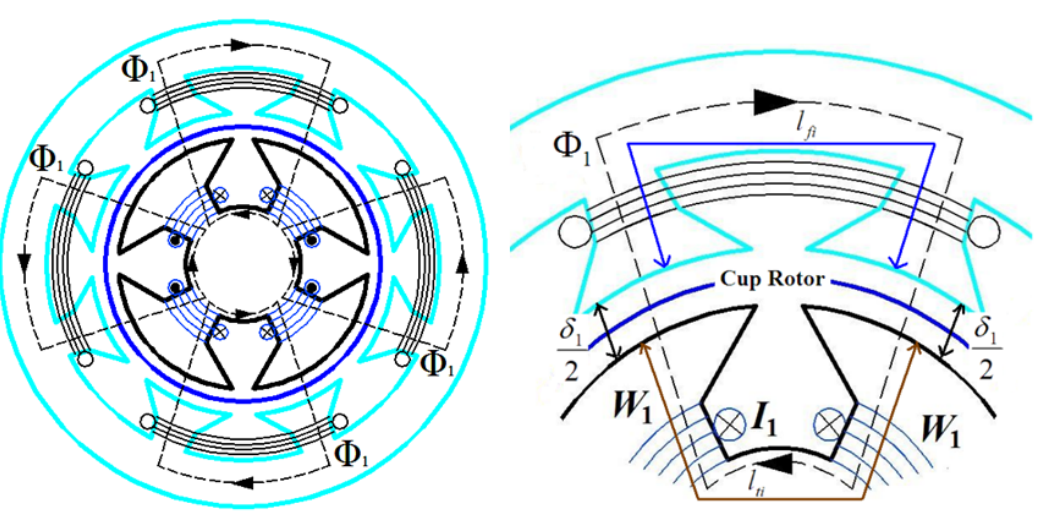
Figure 4. The magnetic circuit of Ф